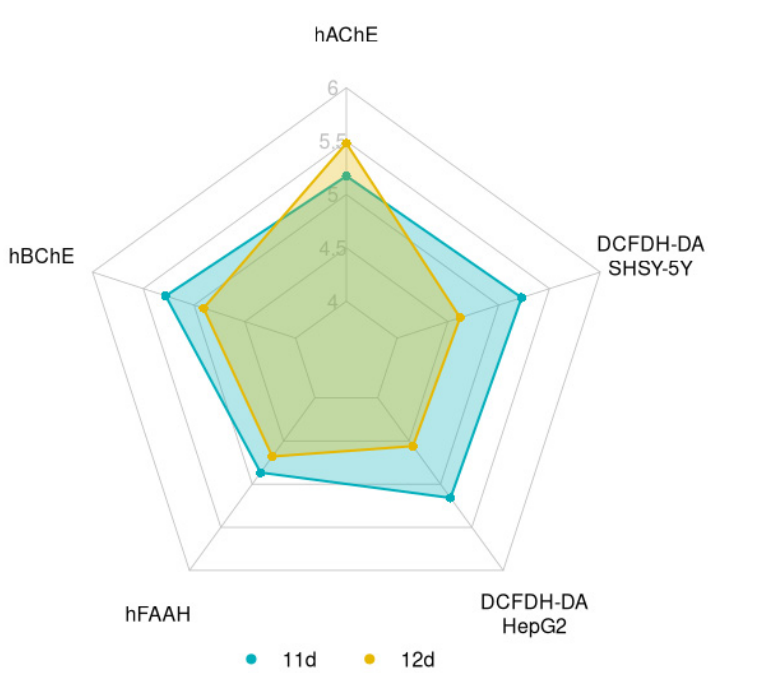
Figure 2. Summary chart representing the biological activities of 11d (blue area) and 12d (orange area). Data are reported as pIC 50 .